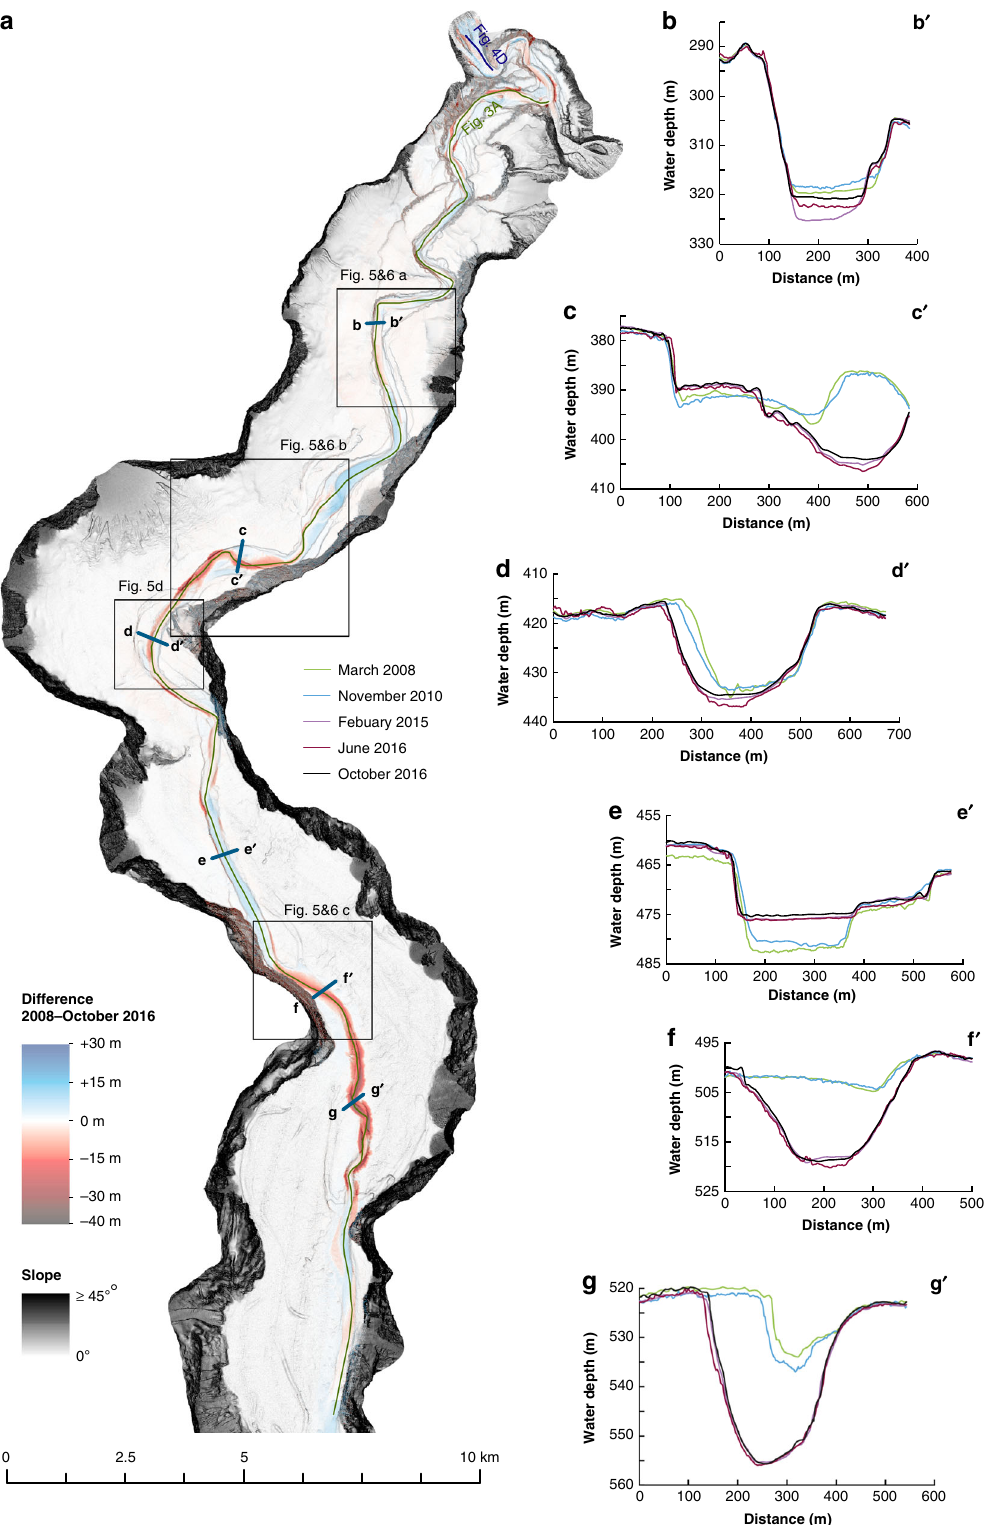
Fig. 2 Changes in the submarine channel in Bute Inlet. a Map of changes in seabed elevation between March 2008 and October 2016, overlaying a seabed gradient map. Note the alternations of deposition and erosion along the channel. b - g Changes in seabed elevation at a series of cross-sections. Locations are shown in panel a . 10x vertical exaggeration. b The channel gradually fi lls except during knickpoint migration between 2010 and 2015, when previous deposits are eroded. c Lateral migration of channel thalweg as a result of knickpoint migration. Note how the channel fl oor in 2008-2010 becomes a terrace from 2015 onwards. d Section showing largest observed amount of outer-bend erosion away from migrating knickpoints. e Progressive fi lling of a channel in a depositional area. f Knickpoint migration creates a channel, where the channel was previously shallow and poorly-de fi ned. g Cross section at a location affected by both outer-bend erosion and knickpoint